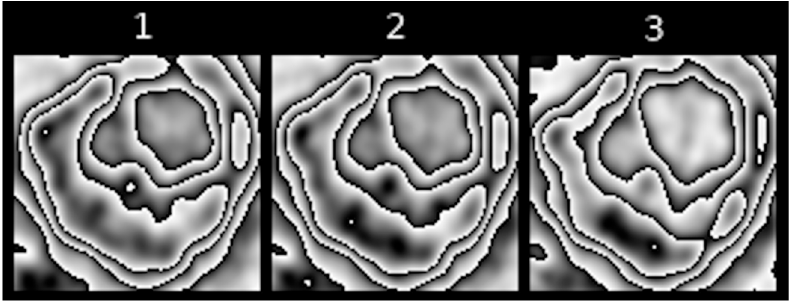
Figure 8. Example of a considerable shift in the location of maximum [18F] FDG uptake in a sequence of PET images of a pulmonary nodule.